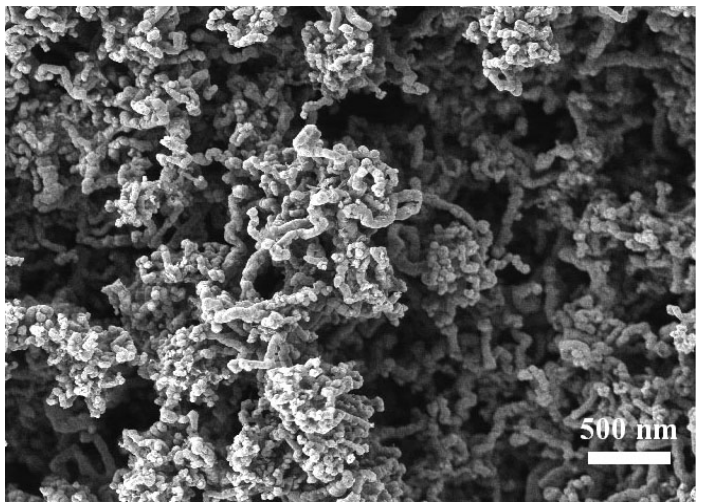
Figure 4. The SEM image of the as-fabricated carbon nanotubes. The carbon nanotubes are about 25-50 nm in diameter, and 50 µm in length.